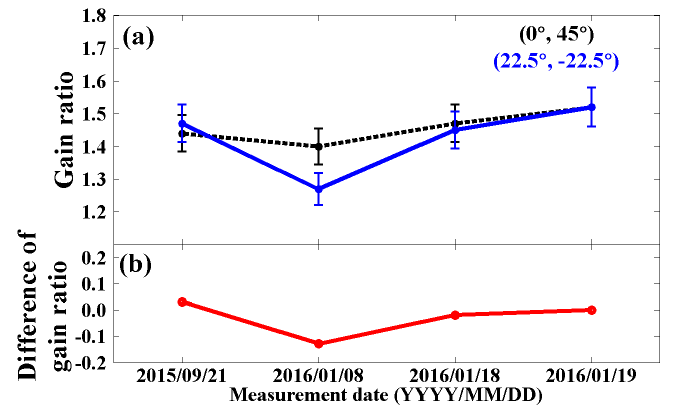
Figure 5. The ( a ) value and ( b ) deviation of gain ratios measured with different measurement groups of (0 ° , 45 ° ) and (22.5 ° , − 22.5 ° ) in Qingdao.